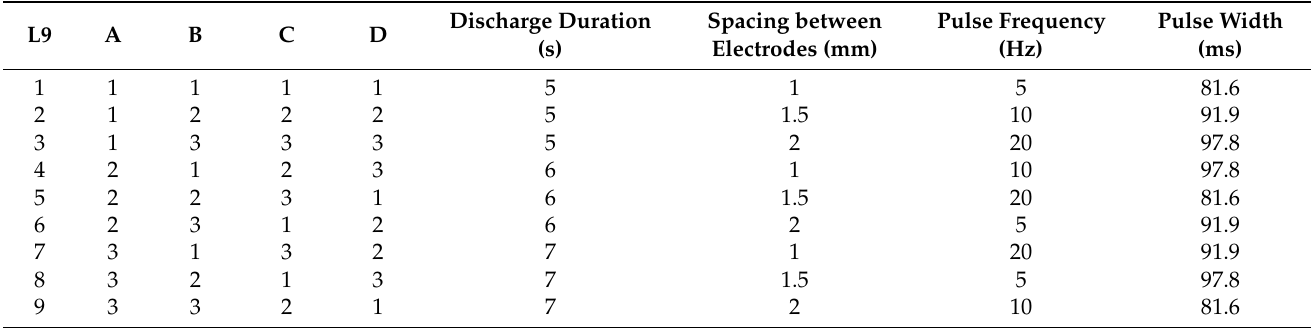
Table 3. Orthogonal array of L9 (34).